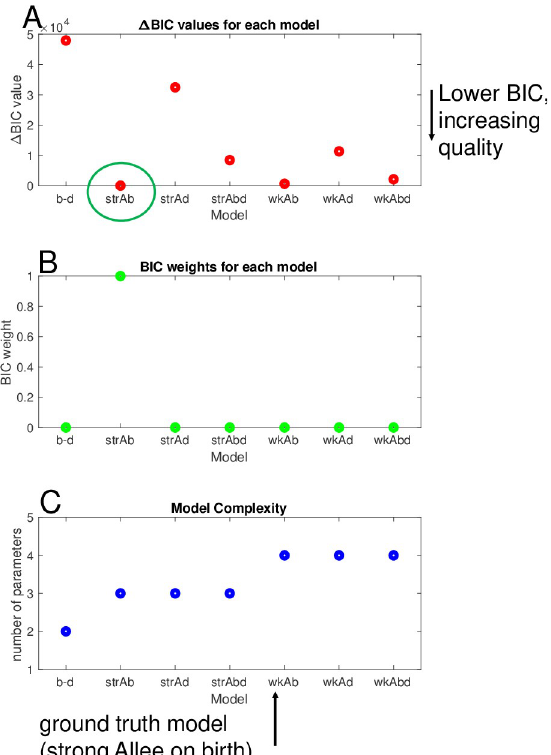
Fig 4. Model selection based on the BIC identifies the ground truth model in simulated data. (A) Δ BIC values ) are plotted for the fit of the simulated data set to each of the 7 models from left-to-right: simple birth– ( BIC i − BIC min death model ( b − d ), strong Allee model on birth (str Ab ), strong Allee model on death (str Ad ), strong Allee model on birth and death (str Abd ), weak extended Allee model on birth (wk Ab ), weak extended Allee model on death (wk Ad ), and weak extended Alee model on birth and death (wk Abd ) compared with the highest quality, minimum BIC value model: the strong Allee model on birth. (B) BIC weighting reveals strong evidence to choose the strong Allee model over the other candidate models. (C) Number of parameters of each model as a measure of relative complexity of the model. The data and code used to generate this figure can be found at https://github.com/brocklab/Johnson- AlleeGrowthModel.git. BIC, Bayesian Information Criterion.